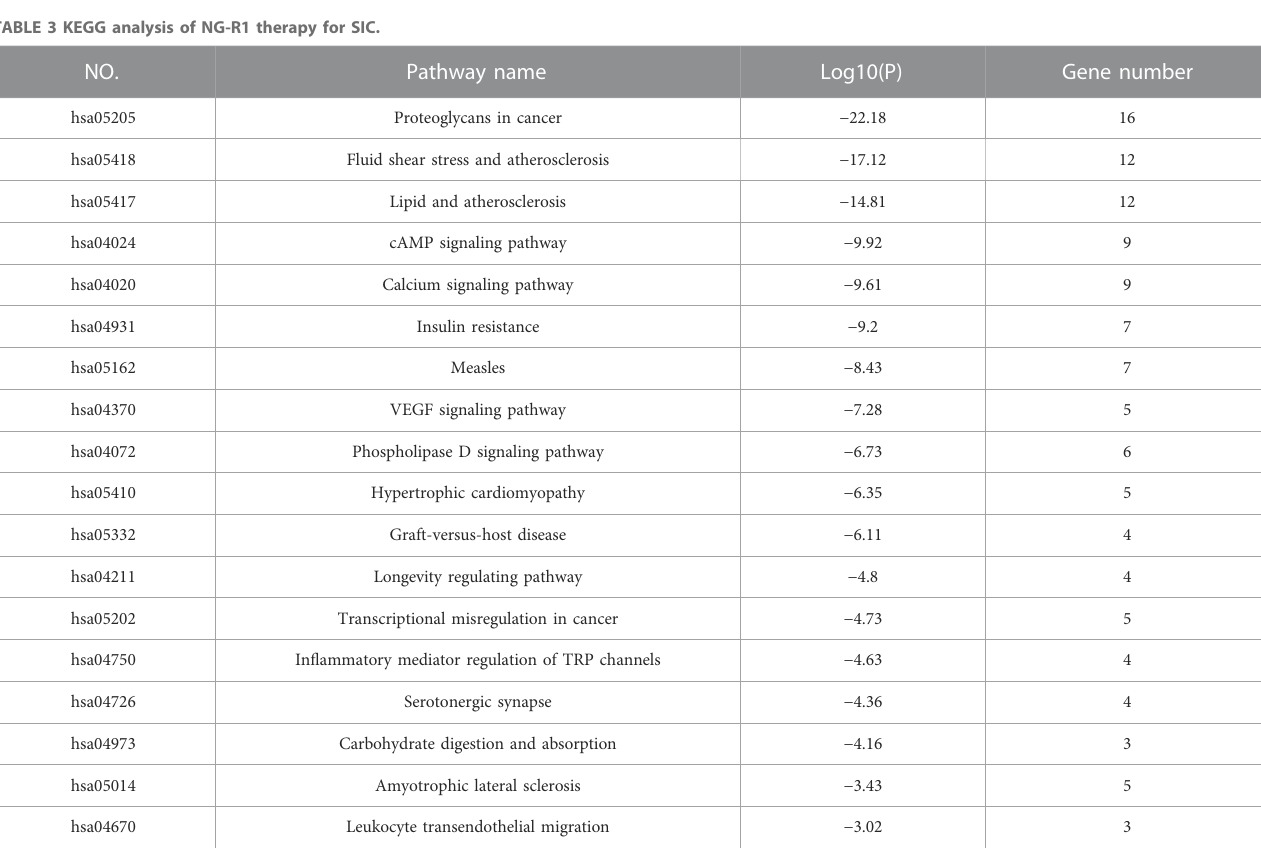
TABLE 3 KEGG analysis of NG-R1 therapy for